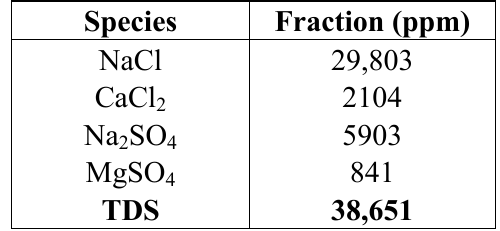
Table 1. Synthetic brine